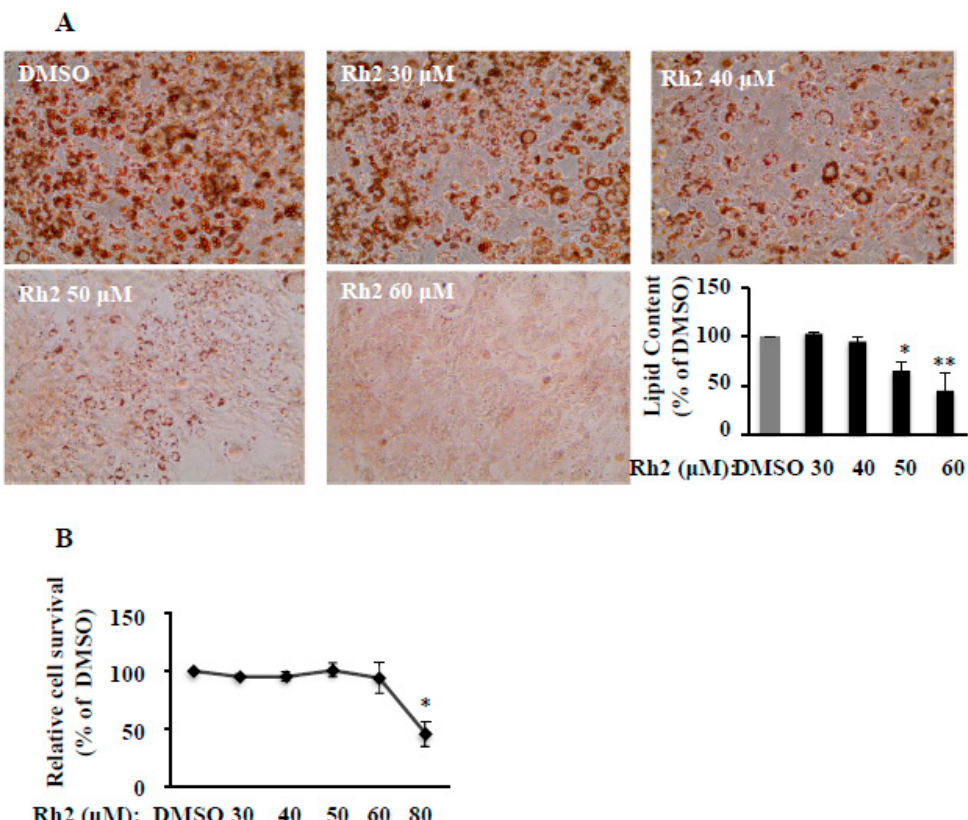
Figure 1. Ginsenoside Rh2 dose-dependently inhibits cell differentiation in 3T3-L1 cells. The cells were induced to differentiation by 3-isobutyl-1-methylxanthine (IBMX) + dexamethasone + insulin (MDI) mixture with/out Rh2 for seven days, and then stained with Oil-red O and dissolved in isopropanol. The relative fat accumulation was measured by a Synergy H1 hybrid reader at 490 nm. Oil-Red O representative images of lipid accumulation and the bar graphs are shown ( A , 200 × magnification). A cell toxicity study was measured by an MTT assay ( B ). Values are means ± SE, n = 4. * p < 0.05, ** p < 0.01 vs. dimethyl sulfoxide (DMSO).